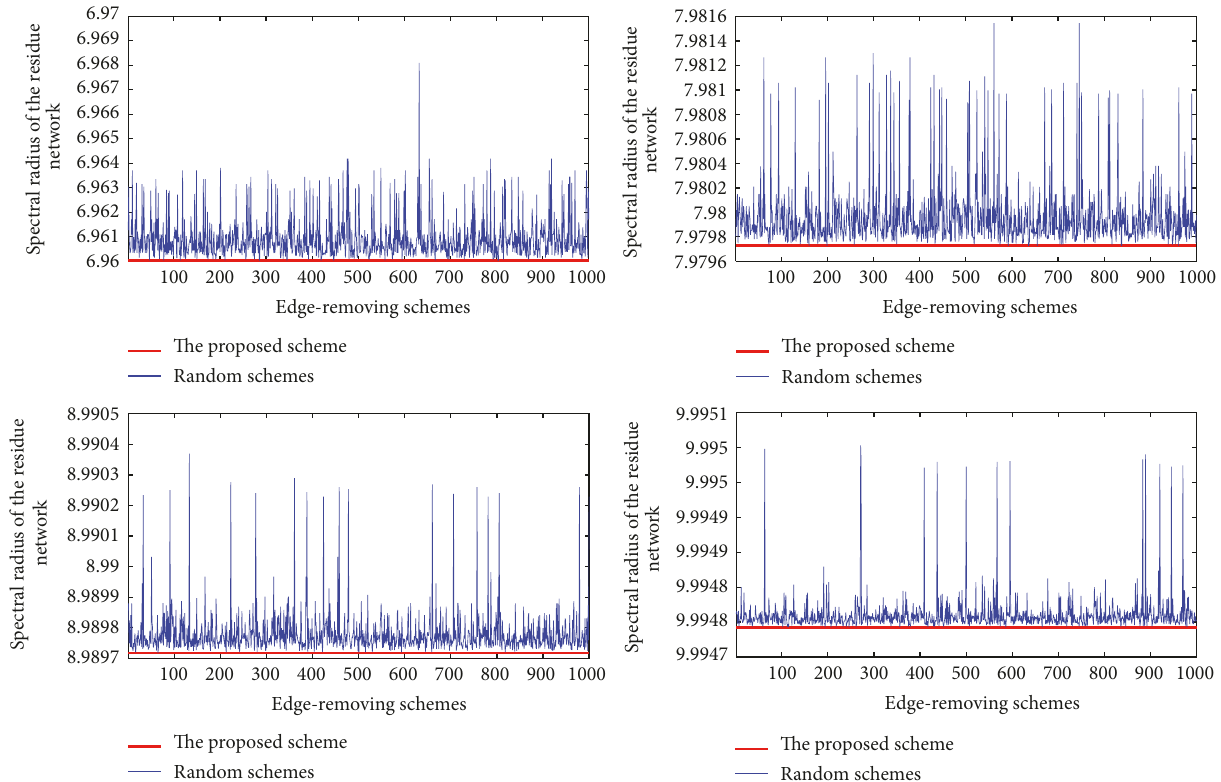
Figure 6: The proposed candidate (red) versus 10 3 random candidates